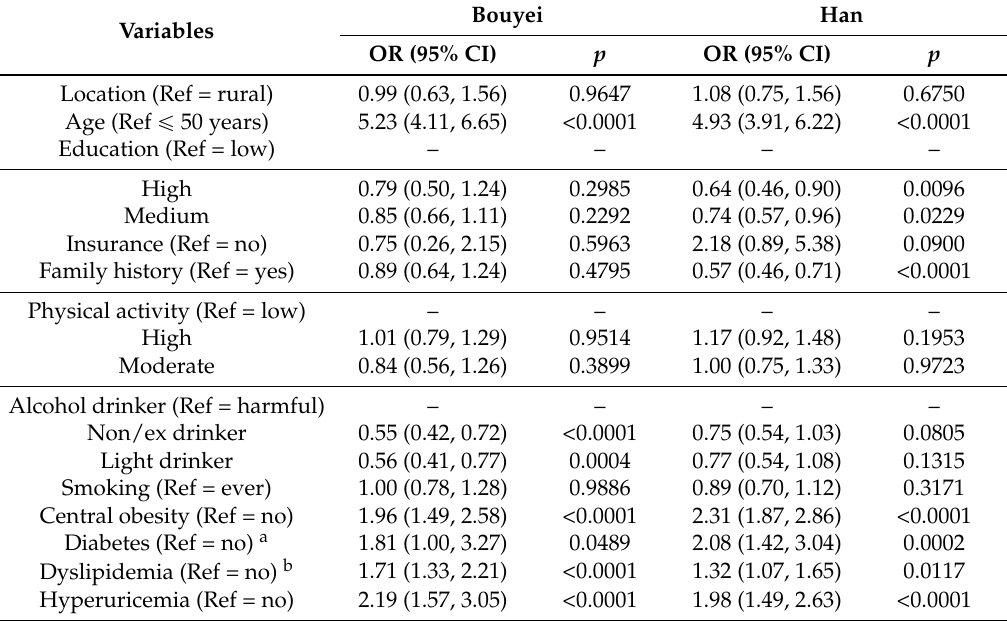
Table 3. Results of Multilevel Logistic Models for Hypertension in Bouyei and Han.